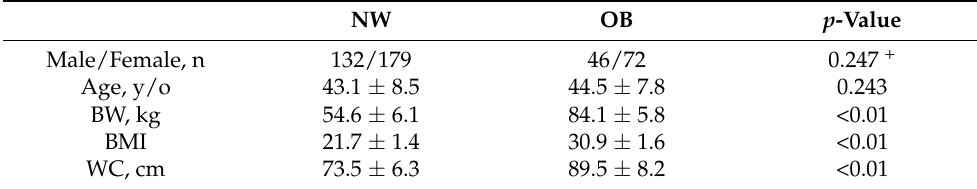
Table 1. The characteristics of participants.